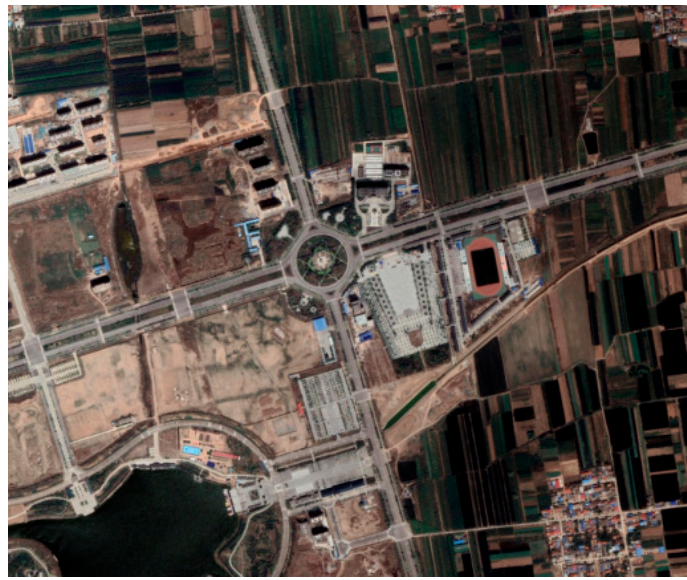
Figure 22. Experimental scene from Google Earth.